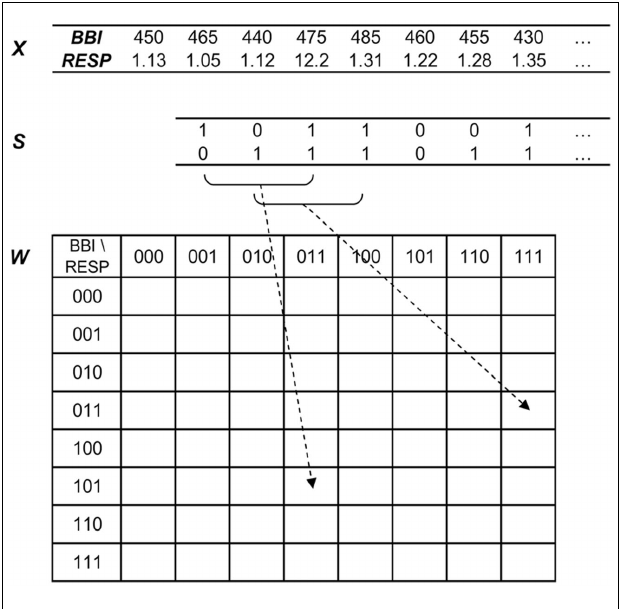
FIGURE 2 | Joint symbolic dynamics – transformation of the bivariate sample vector X [BBI, beat-to-beat intervals; RESP, inspiratory interval time series (s)] into the bivariate symbol vector S (1: increasing values; 0: decreasing and unchanged values) leading to the word distribution density matrix W (8 ×